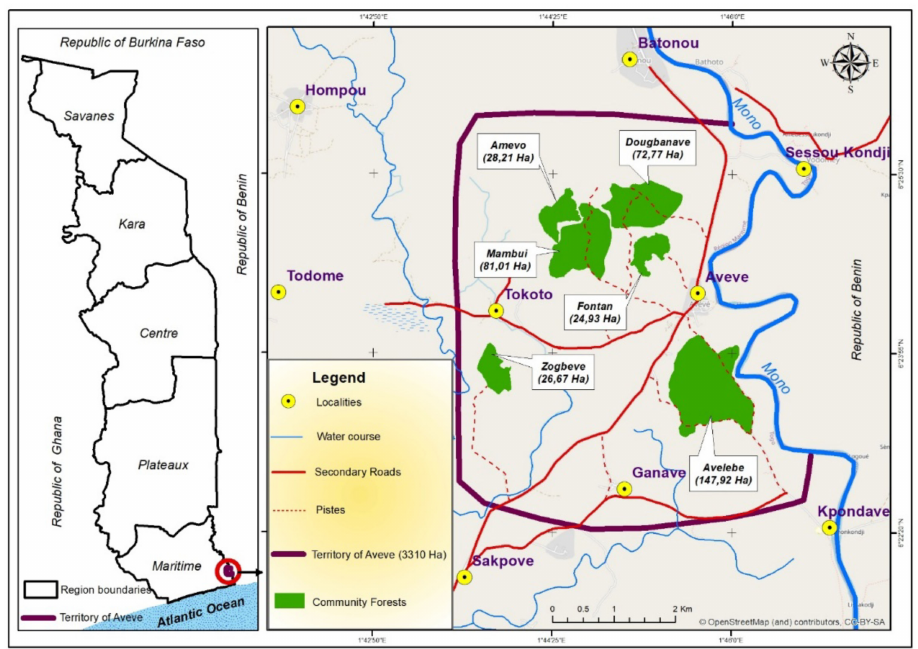
Figure 1. Map of Togo, showing the study area in the south-eastern part of the